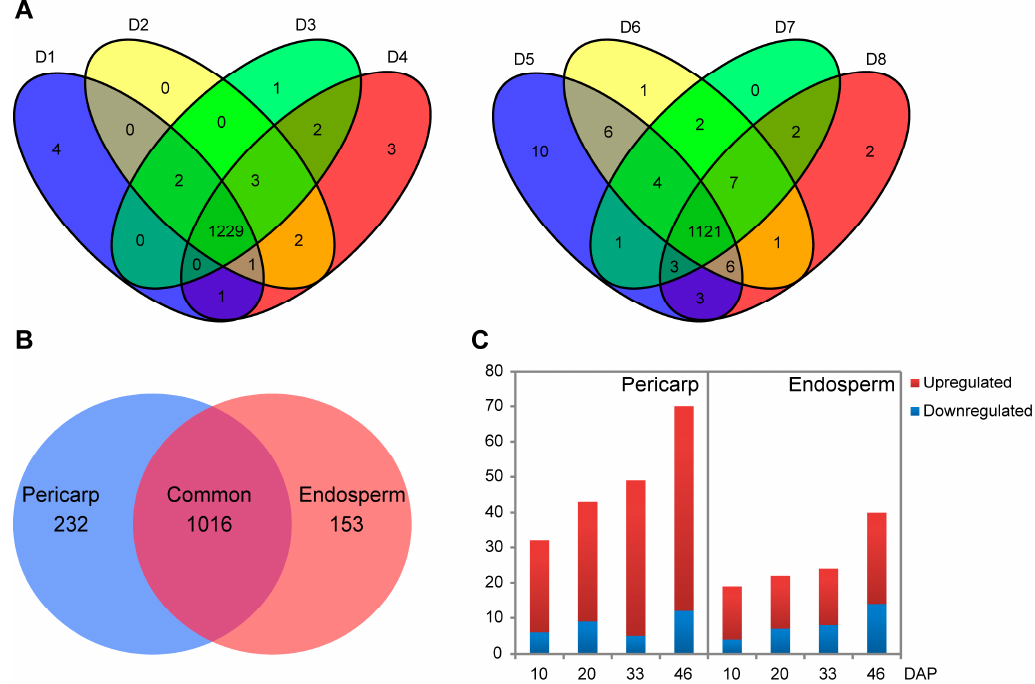
Figure 2. Quantities of differentially expressed proteins according to the developmental stages of the two tissues for inbred Dan232. ( A ) Venn diagrams for identified proteins in the pericarp ( left ) and endosperm ( right ). ( B ) Venn diagram showing the number of proteins in the pericarp and endosperm. ( C ) The numbers of up-regulated and down-regulated proteins in endosperm and pericarp at each developmental stage.